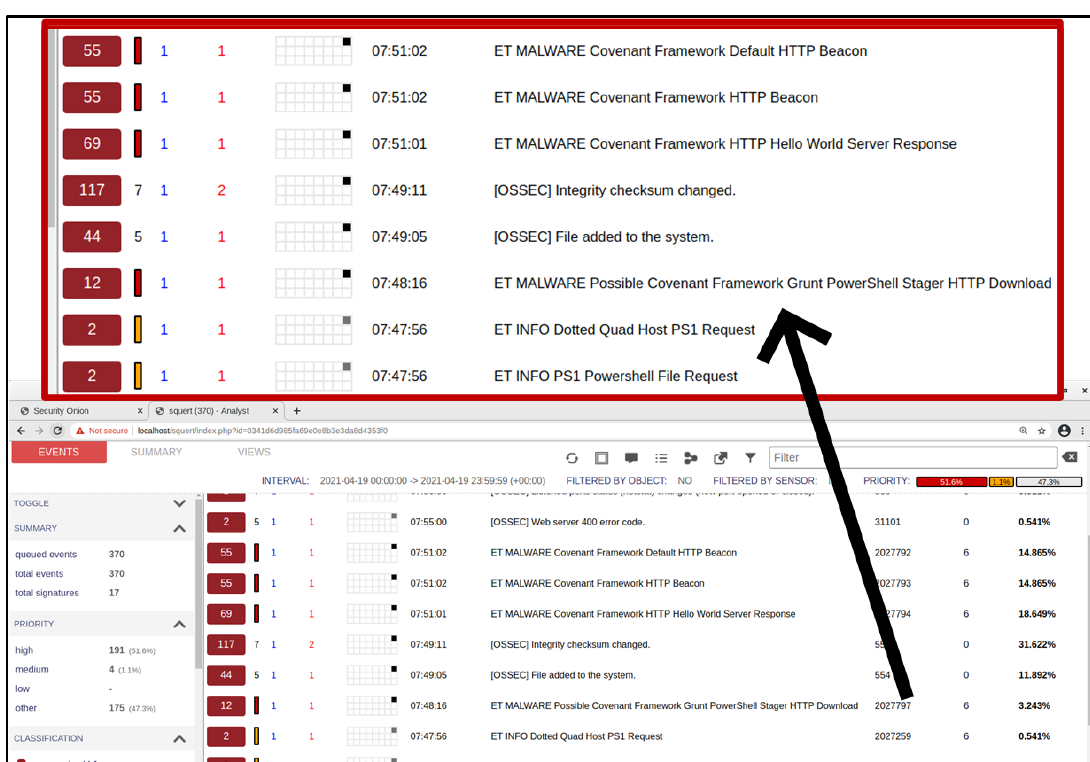
Figure 6. Covenant C2 malicious payload generation.